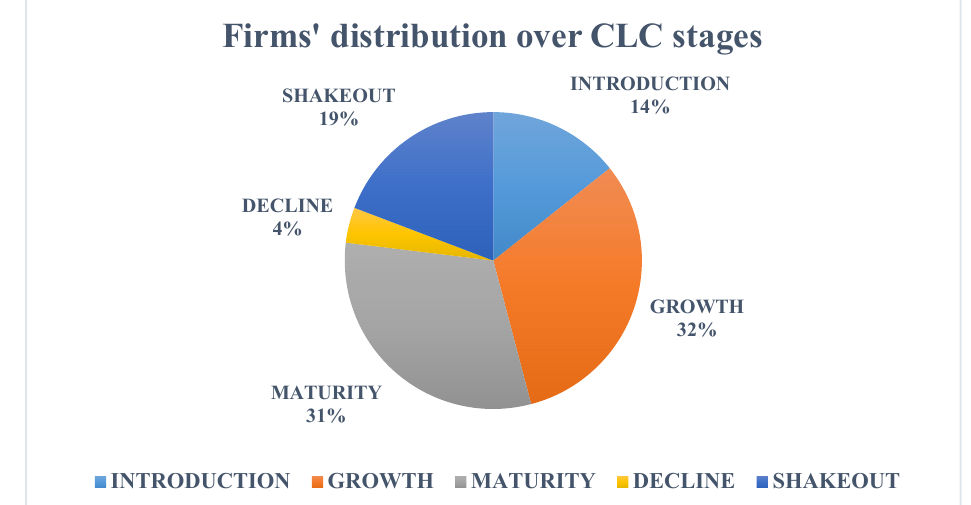
Figure 1. Distribution of sample firms in different CLC stages using Dickinson (2011) model.